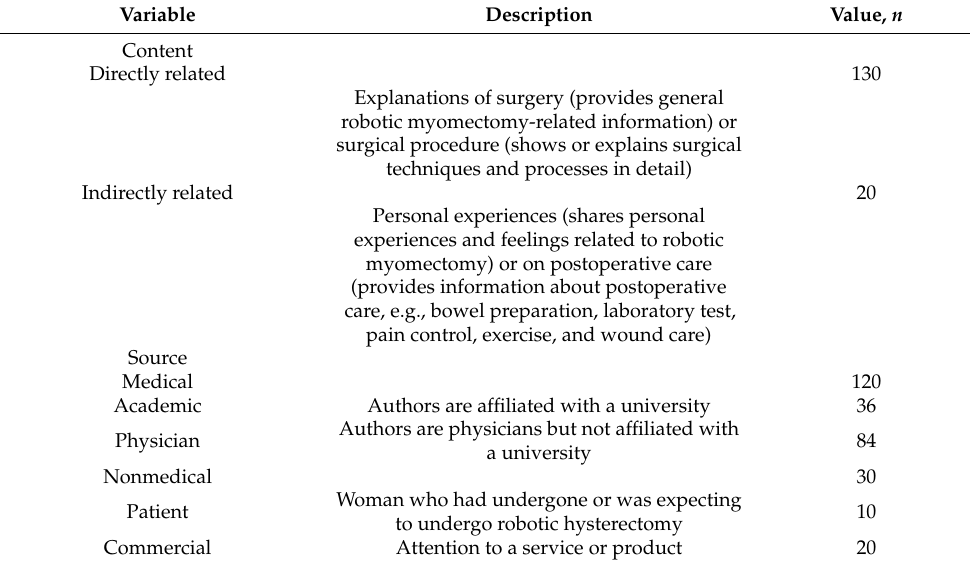
Table 1. Characteristics of robotic myomectomy-related YouTube videos (N = 150).